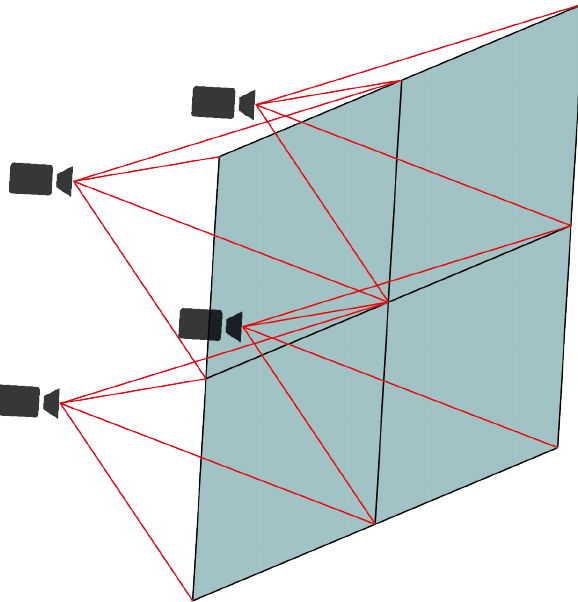
Figure 3. Array of cameras pointing at different views of the